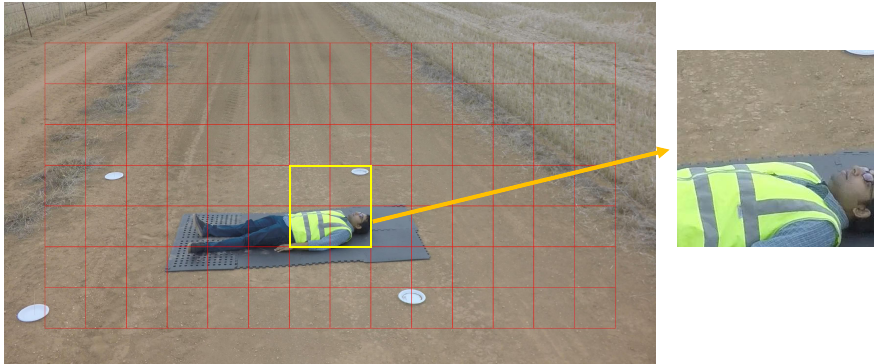
Figure 4. The stabilized video is divided in to tiles as shown in the figure. Each yellow coloured box indicates a tile. The red grid shows the locations where the tiles were selected using a sliding window approach. Each tile has 50% overlap with neighbouring tiles in its row and column. The extracted tile from the yellow colour box are shown on the